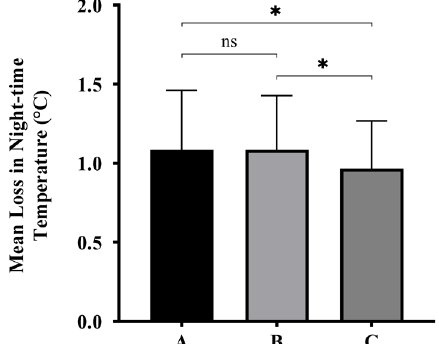
Figure 7. The mean loss in night-time temperature (°C) for each class of ventilation corridors. Bars represent standard deviation and asterisks indicate significant differences between classes